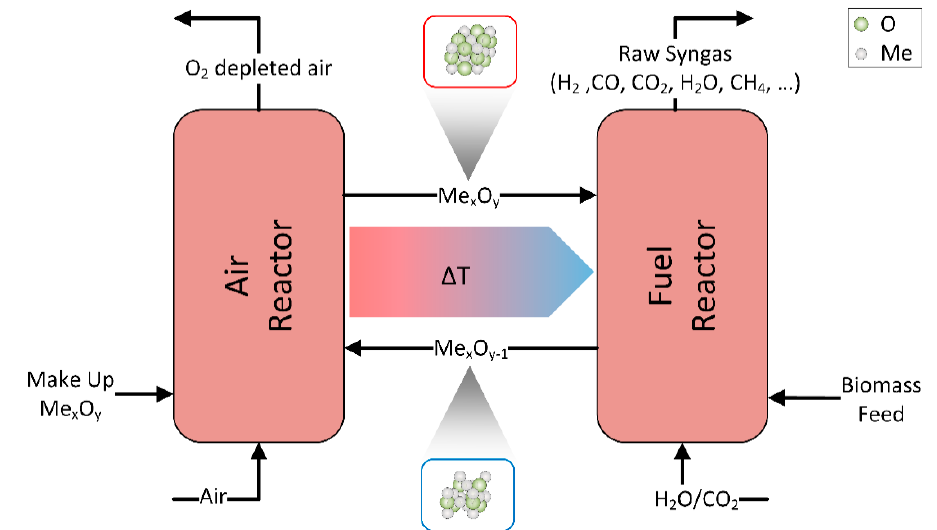
Figure 1. Schematic of the chemical looping gasification process.